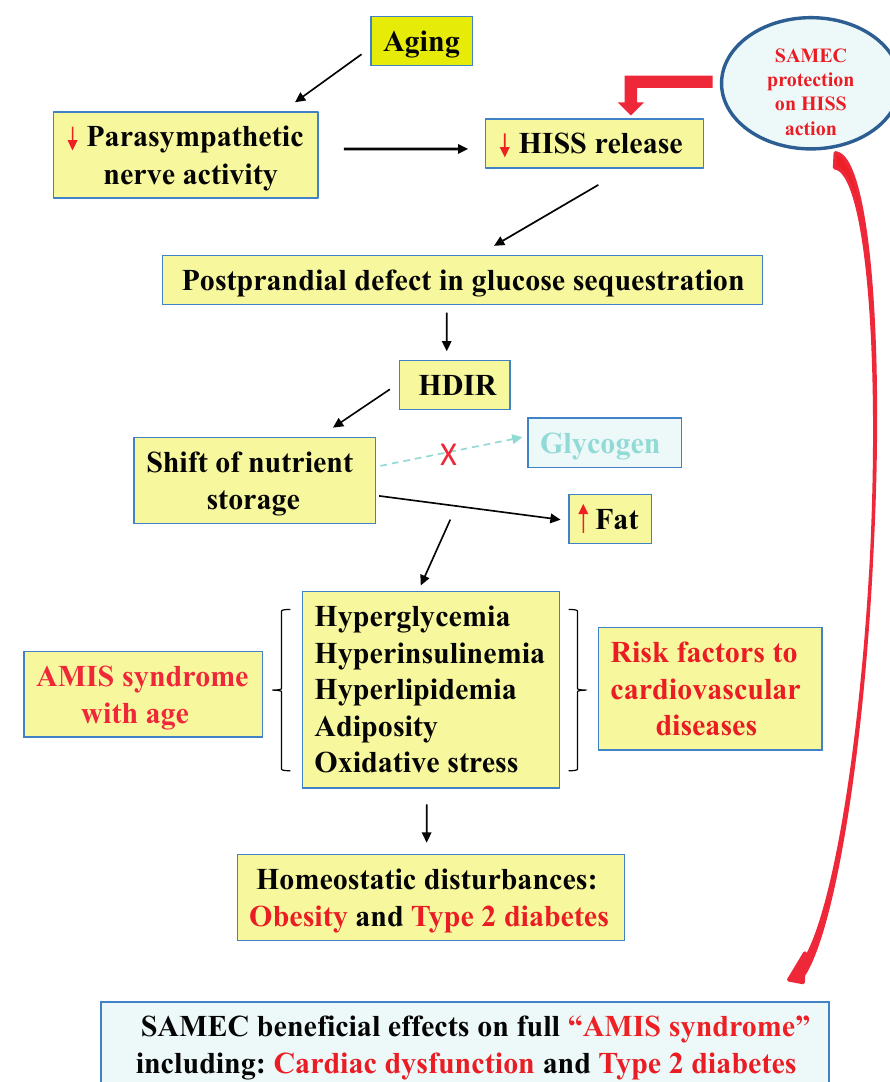
Figure 2. The mechanistic pathway of age-related development of HDIR, AMIS syndrome and antioxidant